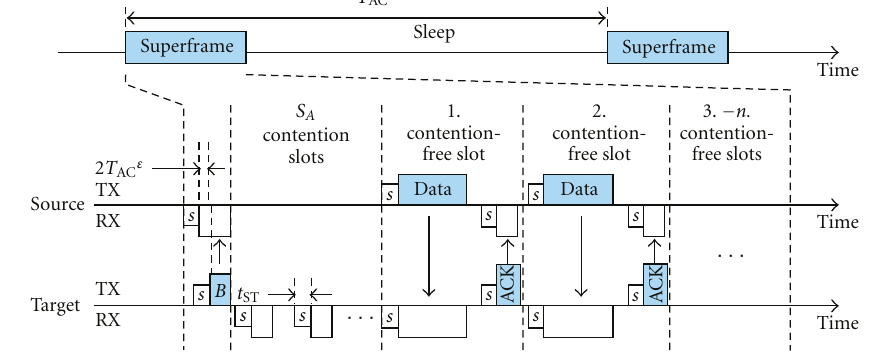
Figure 13: The activity of radio in TUTWSN MAC.